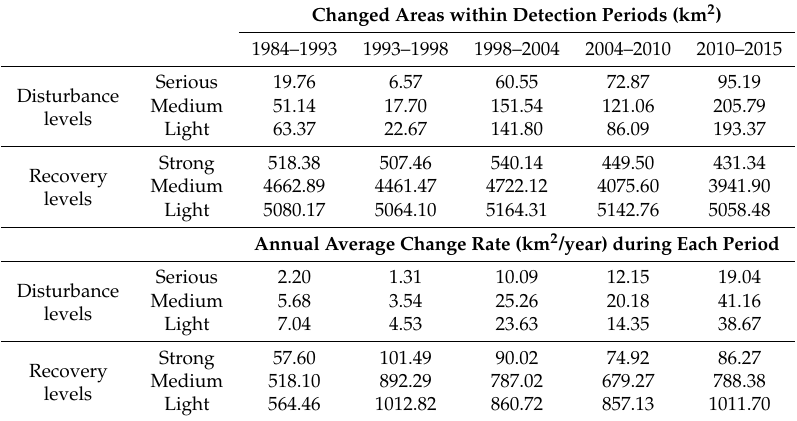
Table 4. Statistical Results of Forest Disturbance and Recovery Areas (km 2 ) and Corresponding annual Change Rate (km 2 /year) for Each Detection Period.